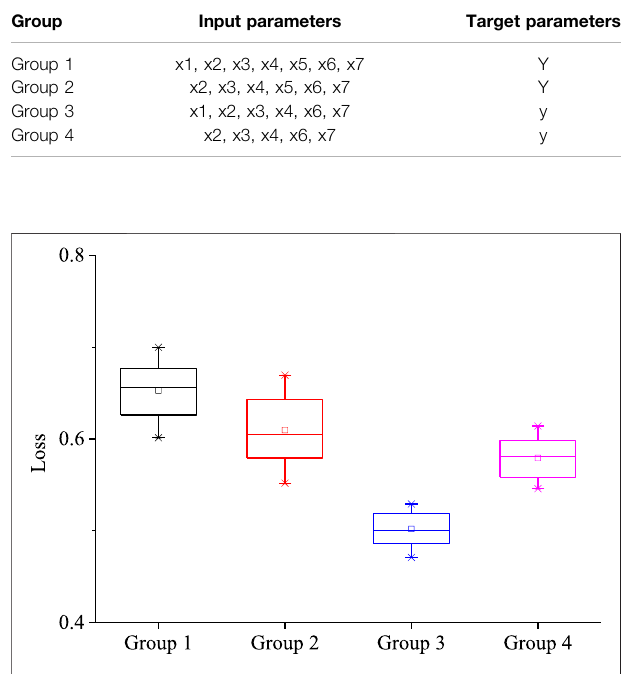
FIGURE 5 | Fitting performance of different input